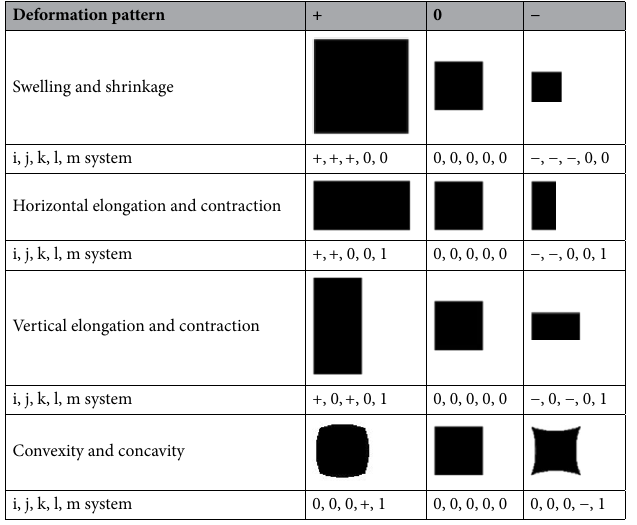
Table 3. Deformation patterns of reference geometric